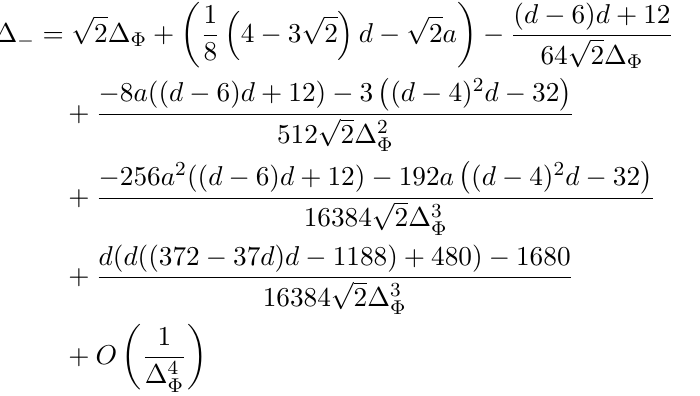
(b) (cid:1) + ; (cid:1) (cid:0) vs (cid:1) (cid:30) for d = 4. Figure 6. Solid lines represent (cid:1) + ; (cid:1) (cid:0) calculated using exact block while dashed lines are eq. (5.6),dashed lines represent a = 1 and dotted are a = 0. We have included here only d = 2 ; 4 but the feature is similar for d = 1 ;